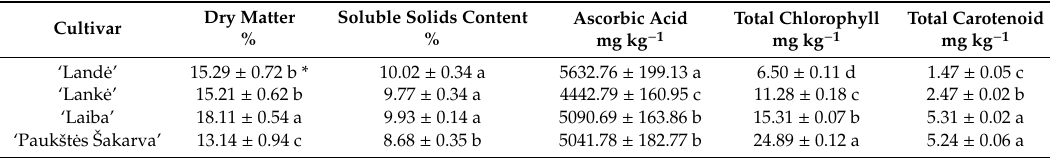
Table 1. Chemical composition of Actinidia kolomikta fruit at harvest.